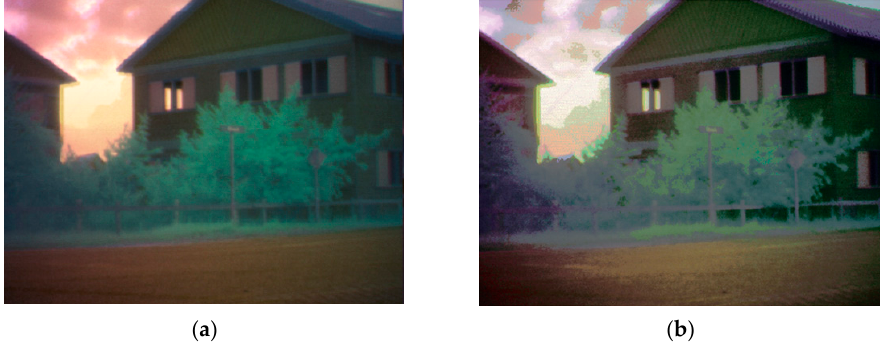
Figure 3. Examples of ( a ) Toet [41]; and ( b ) Pitié et al. [76].